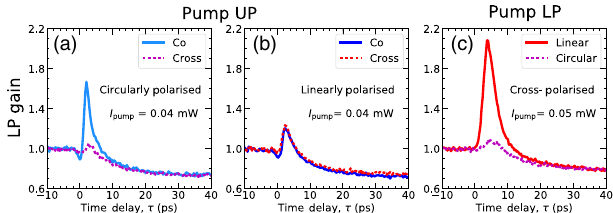
FIG. 4. Evolution of lower-polariton gain as a function of time delay τ for various pump-probe polarization configurations. LP gain for a given τ is calculated by taking the ratio of the integral under the LP branch at τ to the average integral taken at τ < 0